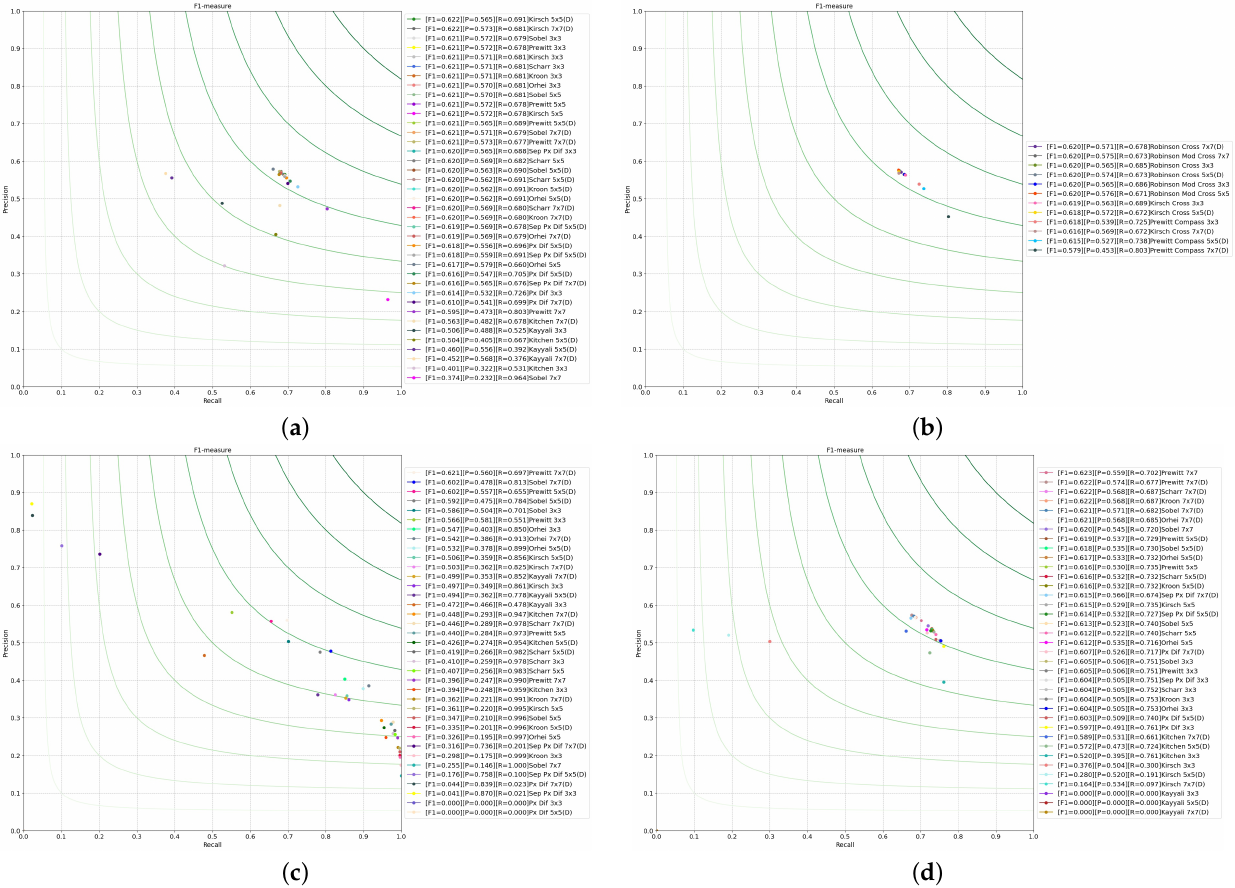
Figure 14. Results for classic, extended and dilated using different operators for: ( a ) first-order derivative orthogonal gradient operators; ( b ) first-order derivative compass gradient operators; ( c ) Canny operator; ( d ) ED edge